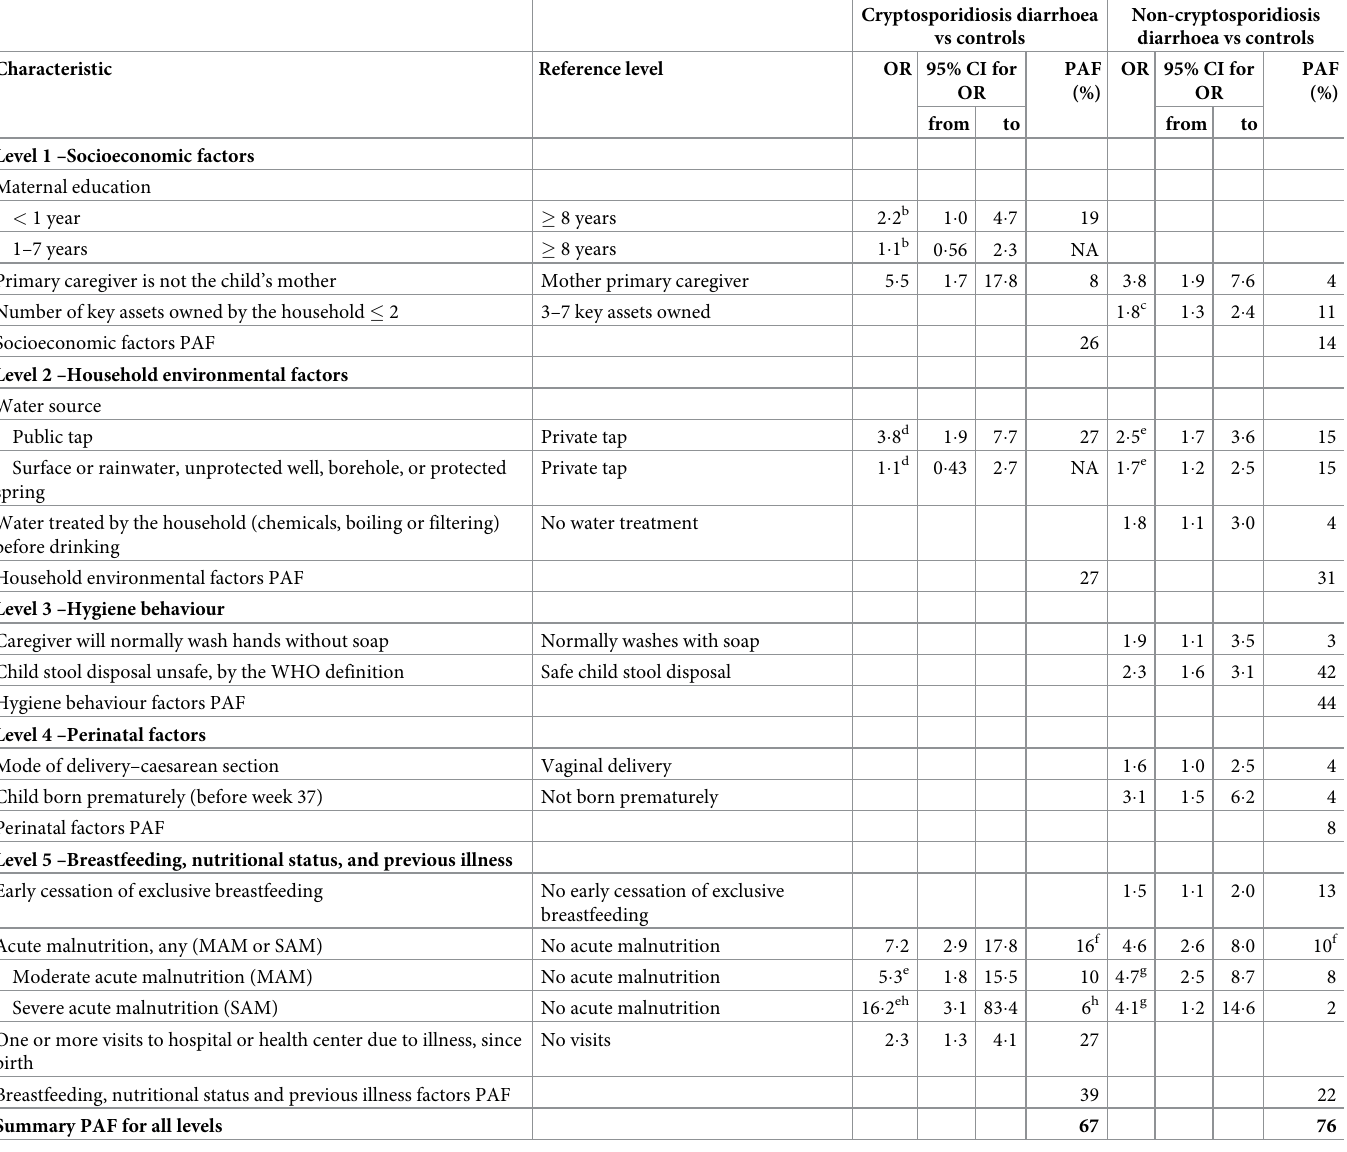
Table 4. Risk factors for cryptosporidiosis diarrhoea and non-cryptosporidiosis diarrhoea in children under 2-years old, compared with non-diarrhoea controls; odds ratios and population attributable fractions estimated from the hierarchical analysis a